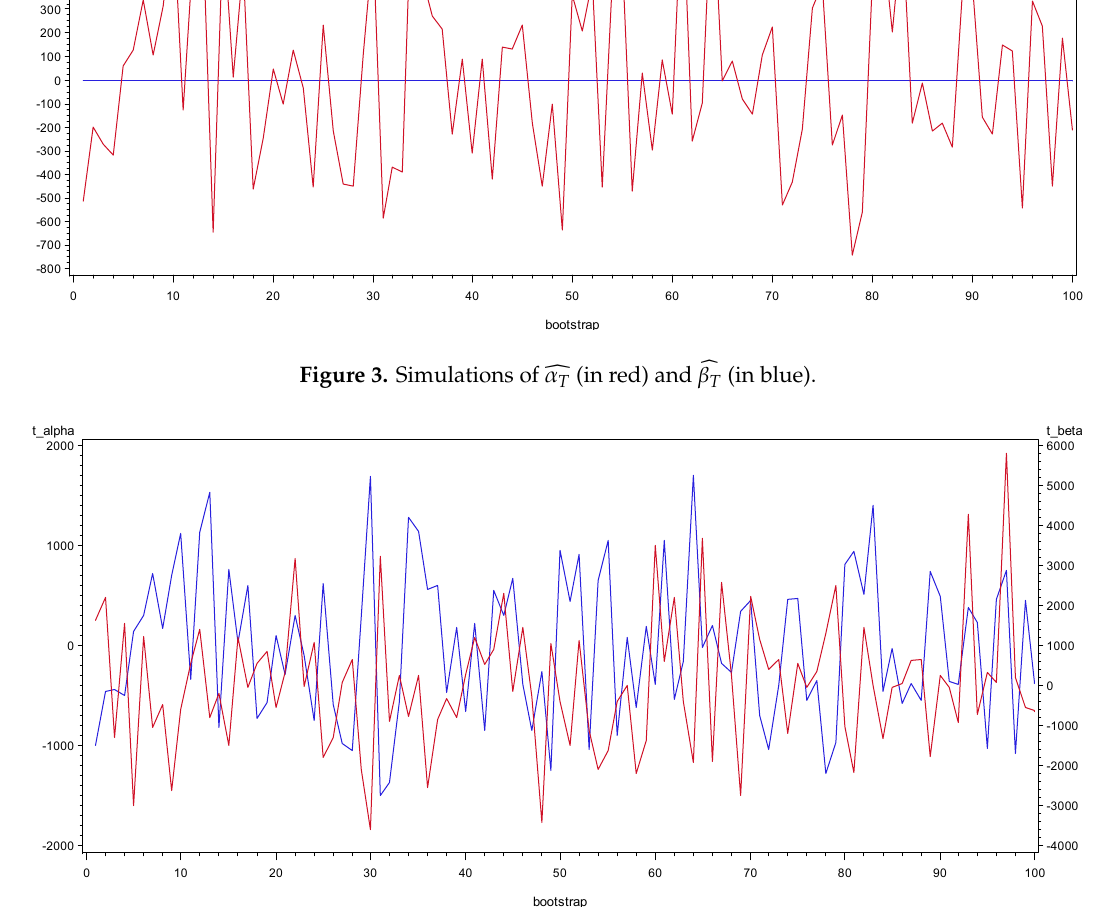
(cid:3550) (in red) and 𝑡 (in red) and (cid:99) t (cid:3269) (cid:3550) (cid:99) α T